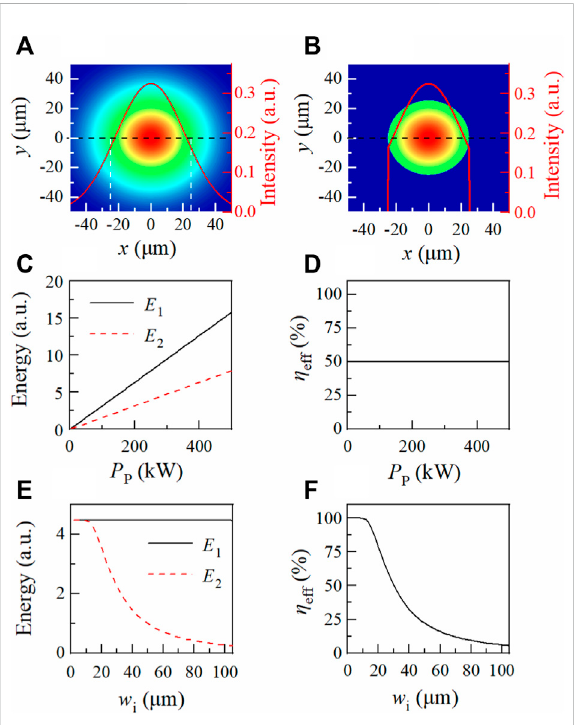
FIGURE 1 (Color inline) Spot intensity patterns before (A) and after (B) entering the fi ber face with the fi ber core radius a (cid:2) 25 μ m [the white dotted lines in (A) ]. The red lines are the cross-section intensity pro fi les. Here, P p (cid:2) 142kW, w i (cid:2) 30 μ m, and (cid:2) 1064nm. Dependences of the energy of the complete and λ 0 partial Gaussian beam E 1 and E 2 , and thecoupling ef fi ciency ofthe fi ber face η eff on (C and D) the peak power 30 μ m and (E and F) the spot size w i for a given P P (cid:2) 142kW.